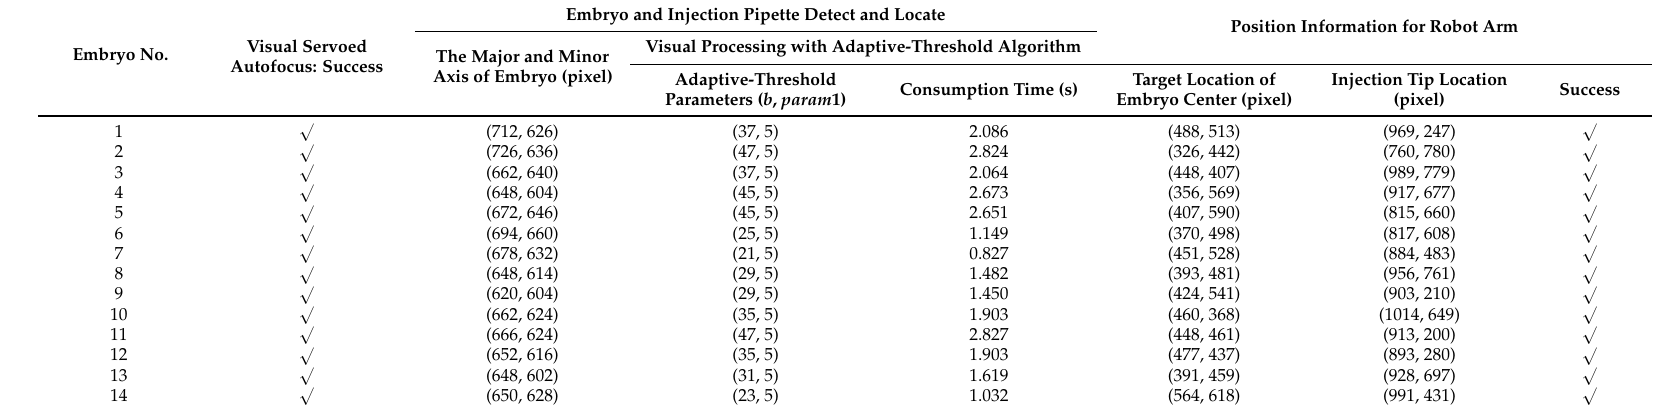
Table 4. Results of the automatic